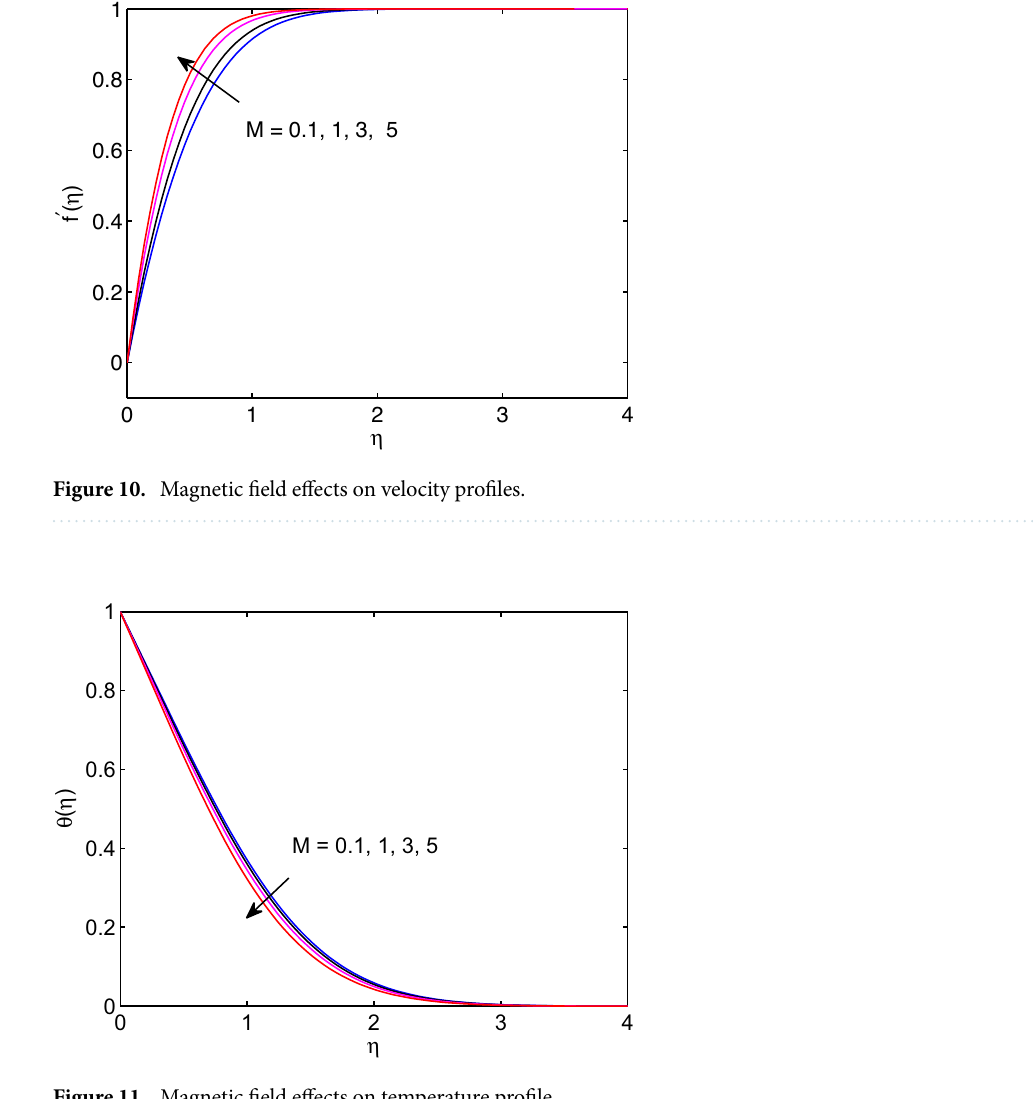
Figure 11. Magnetic field effects on temperature profile.